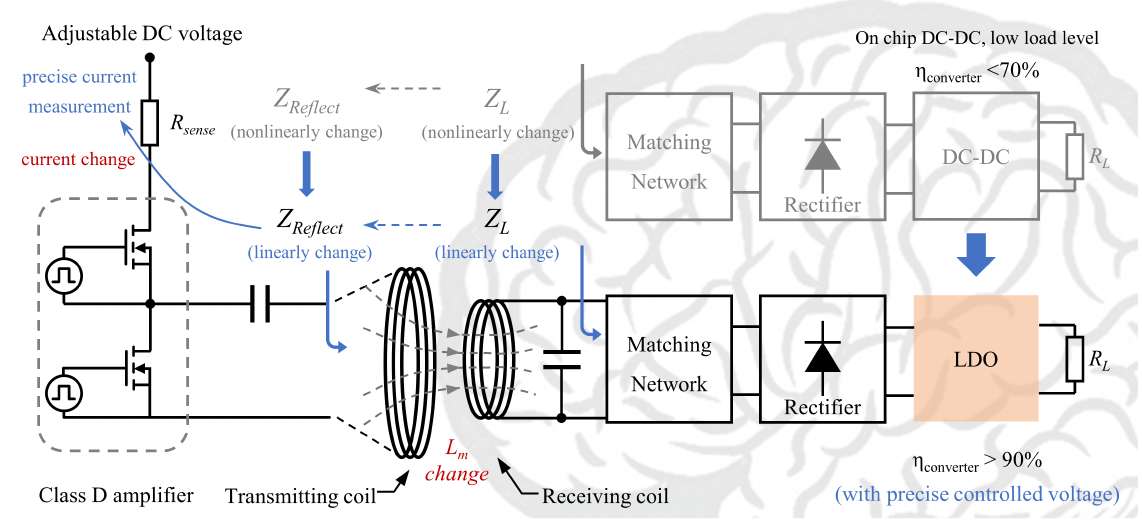
Figure 1. Concept of the linear-power-regulated wireless power transfer